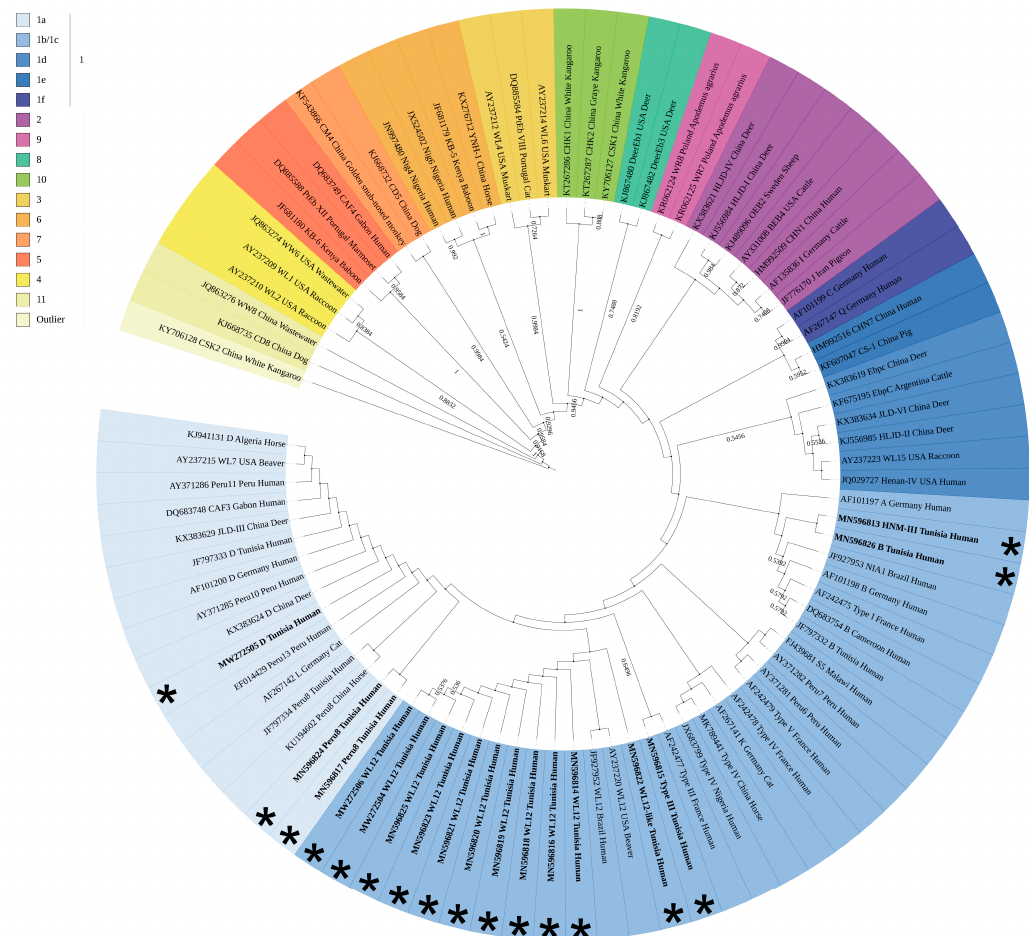
Figure 3. Phylogenetic relationship of the 17 E. bieneusi strains infecting our patient population with a selection of previously published E. bieneusi ITS genotypes representative of each genetic group. The 11 genetic groups and the outlier are indicated with a color code shown on the legend (top left). Bootstrap values are shown on the edges of the tree. The 17 E. bieneusi strains from our patient population are shown in bold and indicated with asterisks. The tree was constructed using a neighbor-joining analysis of the ITS sequences based on the evolutionary distances calculated by the Kimura two-parameter model.